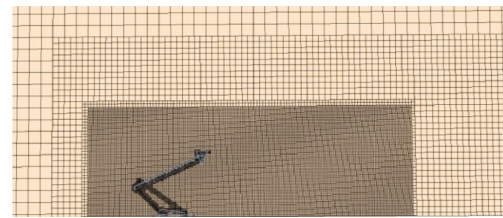
Figure 13: Computation model of improved pantograph.